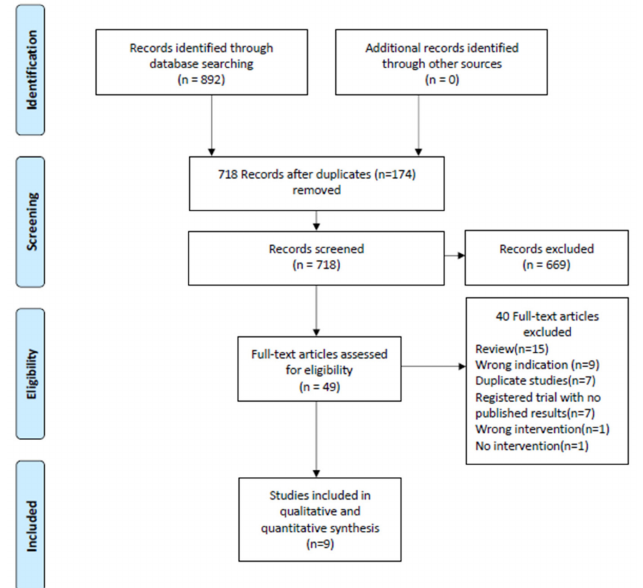
Figure 1. PRISMA flow diagram of assessment of studies identified in the systematic review of fecal microbiota transplantation (FMT) to treat chronic